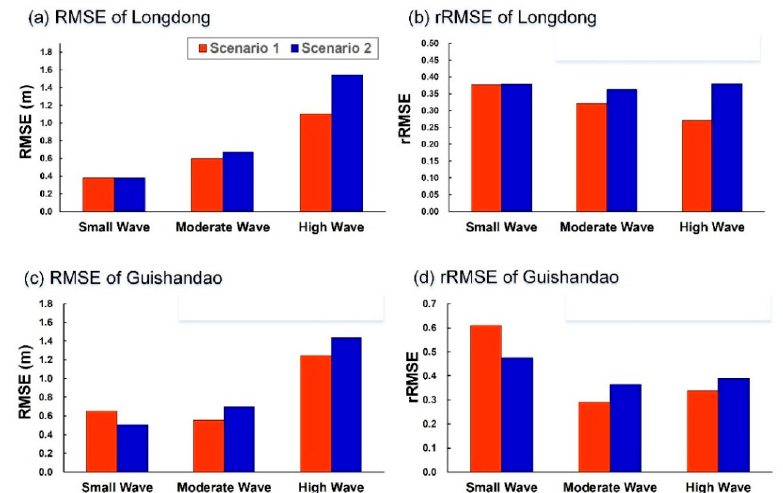
Figure 9. Values of RMSE ( a , c ) and rRMSE ( b , d ) for Longdong and Guishandao according to the wave classification.